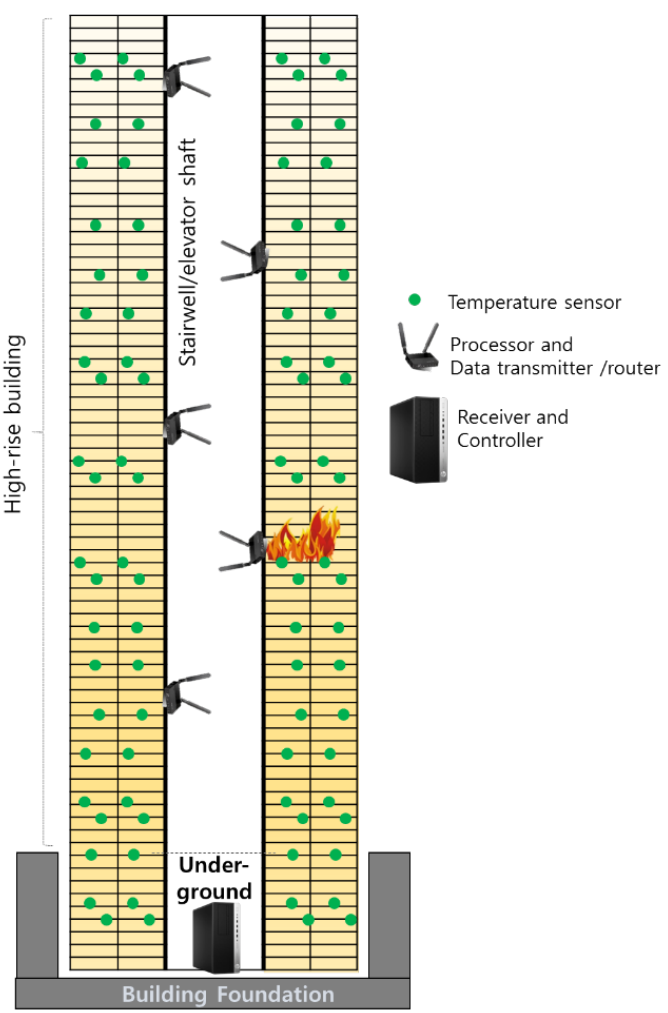
Figure 1. The architecture of the proposed framework in a high-rise building.